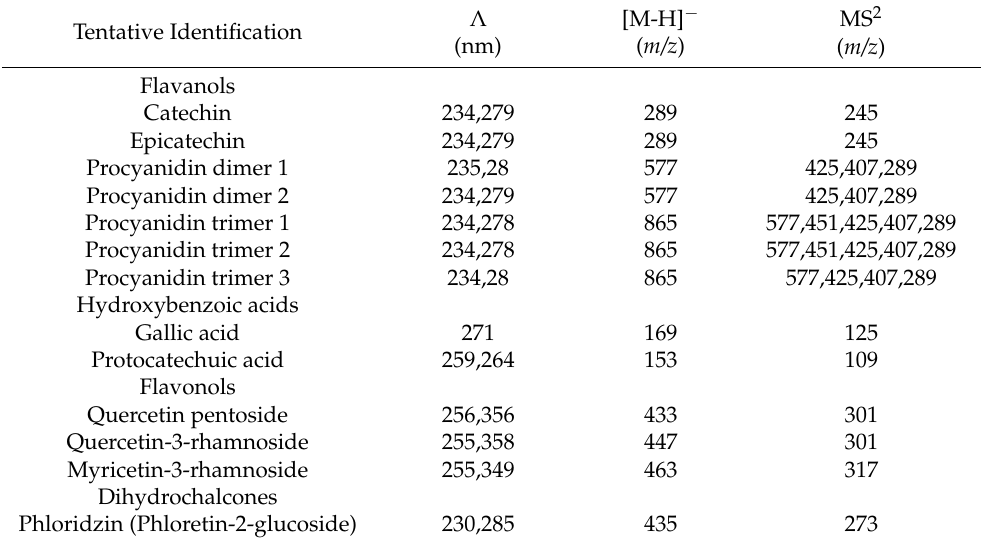
Table 1. The identification of phenolic compounds in hazelnut kernels in negative ion mode using